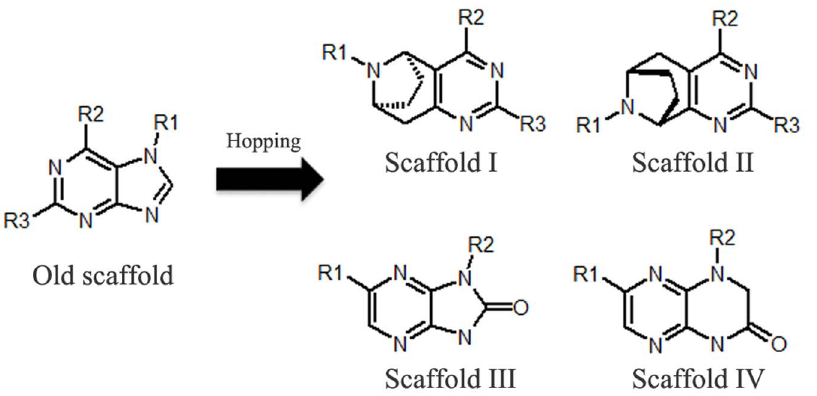
Figure 9. New scaffolds (right) were hopped based on old scaffold (left, contained in train set and test set). R1, R2 and R3 were